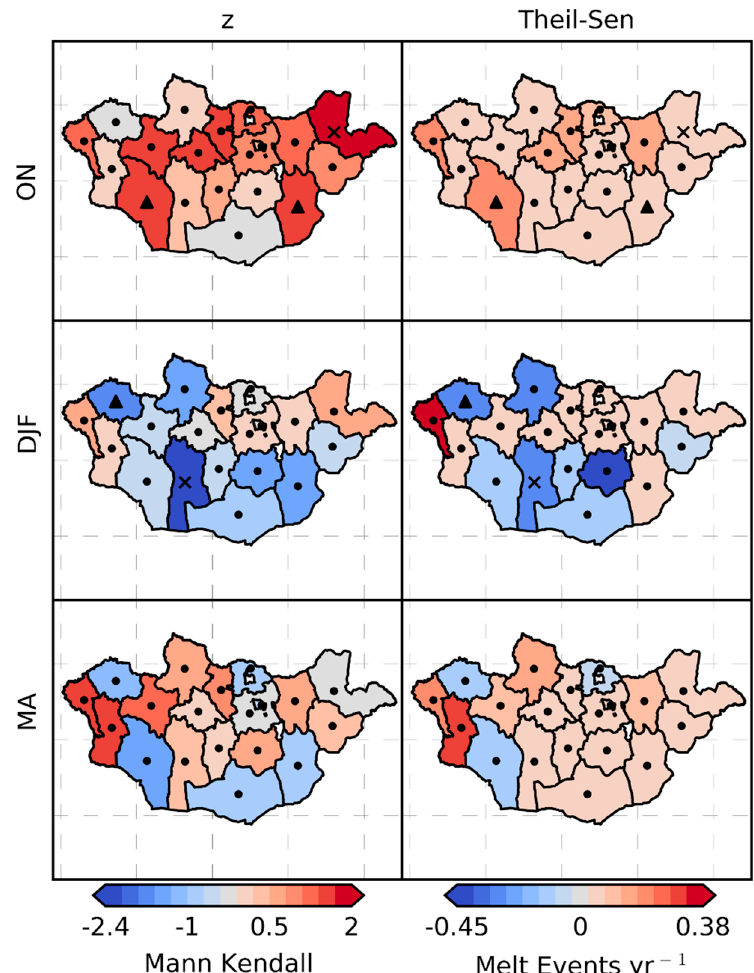
Figure 8. The normalized Mann–Kendall test statistic and Theil–Sen slope trends for melt events across Mongolia for WY 2003–2016. The black dots indicate weak correlations ( p > 0.1), black triangles indicate moderate correlations (0.05 ≤ p < 0.1) and the black ‘x’ symbols indicate stronger correlations ( p < 0.05).